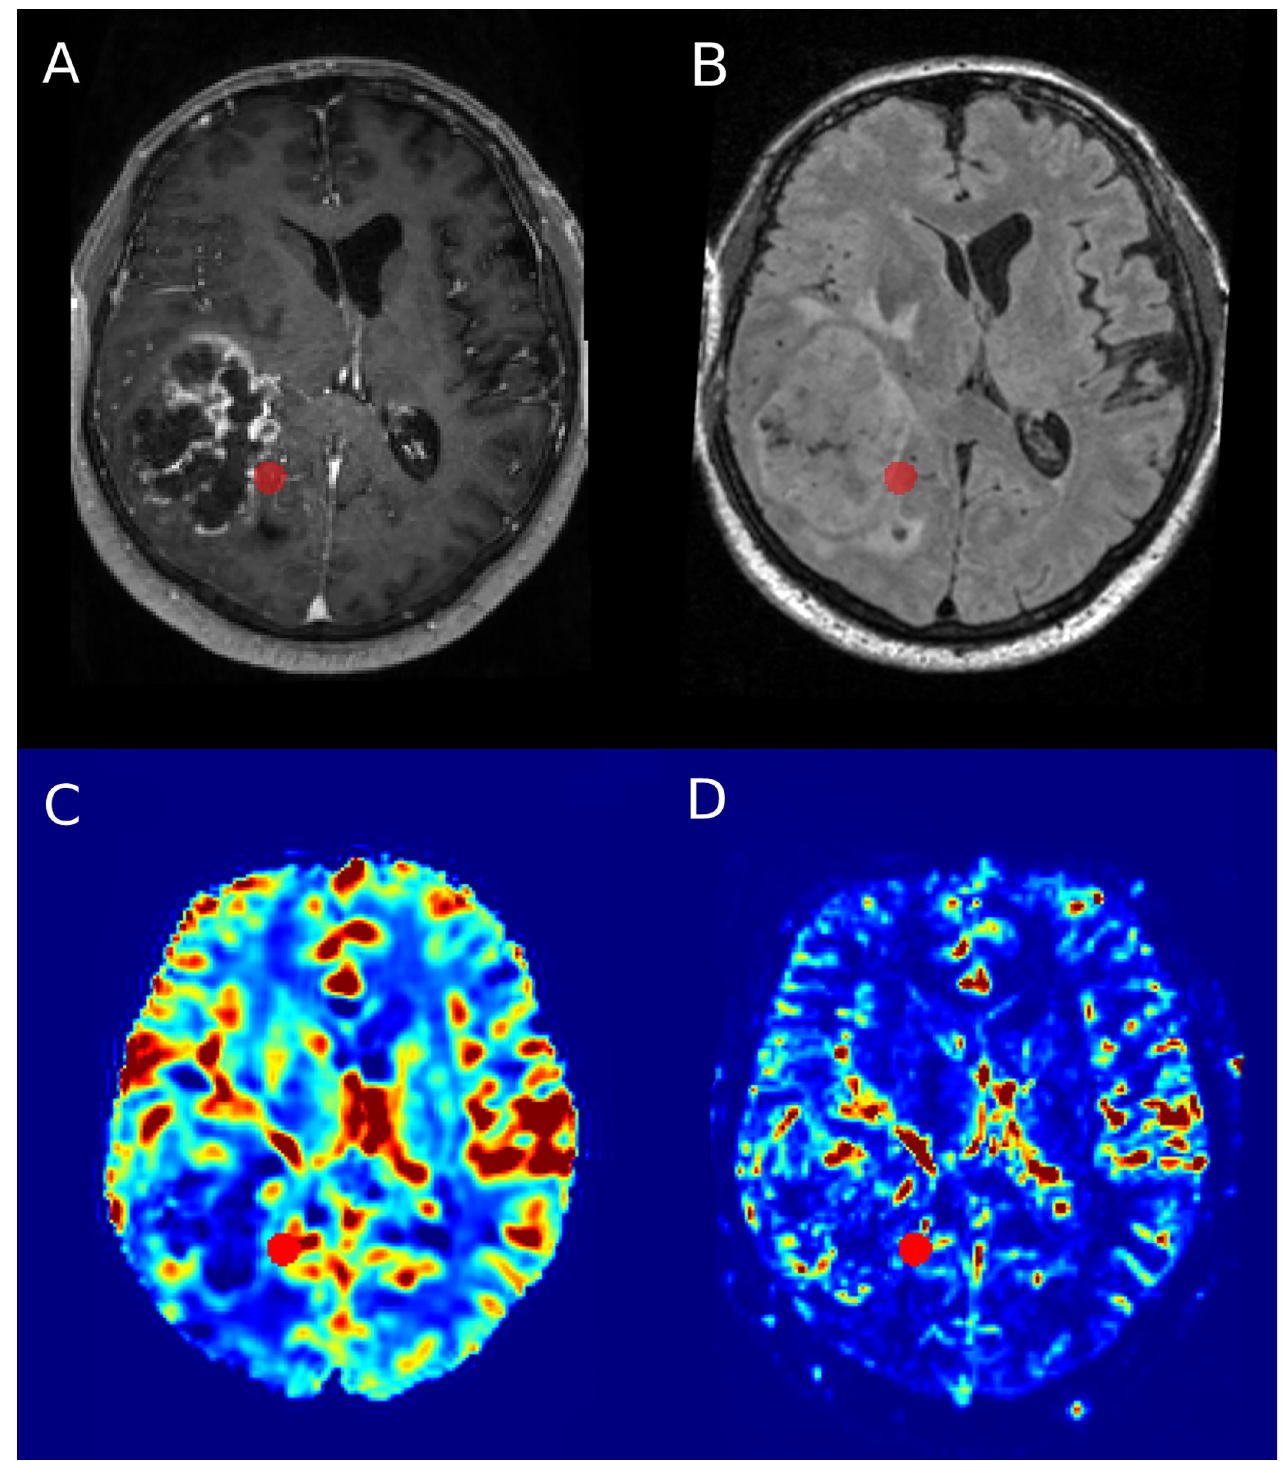
Fig 2. Illustration of VOI placement on spatially corresponding axial contrast-enhanced T1w image (A), FLAIR (B), relative CBV (C) and wavelet-MRP (D).